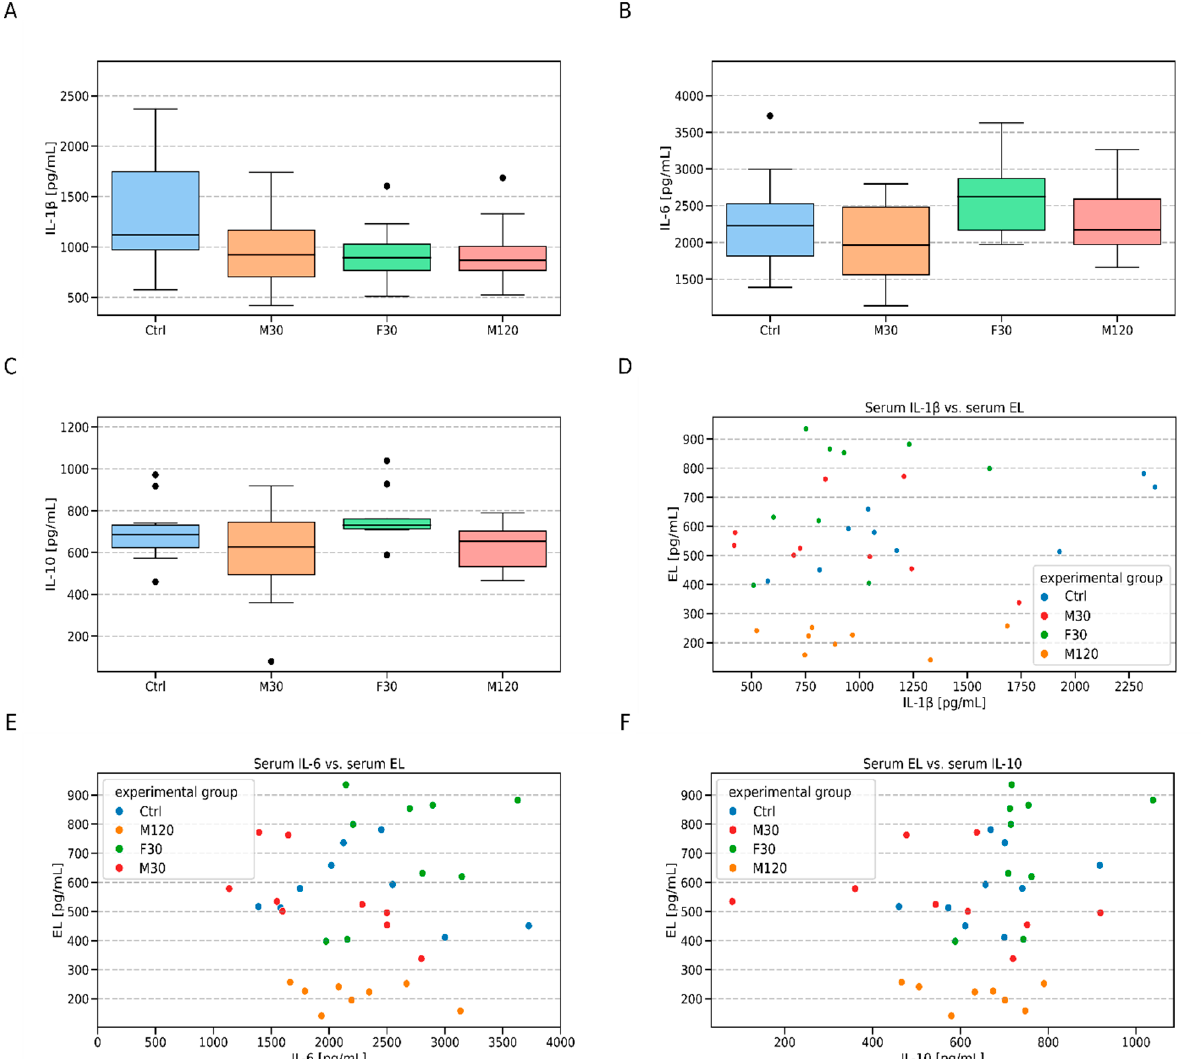
Figure 5. Serum pro-inflammatory IL-1 β ( A ), IL-6 ( B ) and anti-inflammatory IL-10 ( C ) concentration. Correlation between serum IL-1 β and EL concentration ( D ), correlation between serum IL-6 and EL concentration ( E ) and correlation between IL-10 and EL concentration ( F ) in all tested groups. The inner horizontal line of a box represents the median. Box boundaries: 25–75 percentile, box whiskers: 1.5 interquartile range or max/min value in the group. Solid black dot—data point laying outside 1.5 IQR (the interquartile range). The values are expressed in picograms per milliliter of serum. a—difference vs. control (Ctrl), p < 0.05; b—difference F30 vs. M30, p < 0.05; c—difference M120 vs. M30, p < 0.05, n = 10 per group.